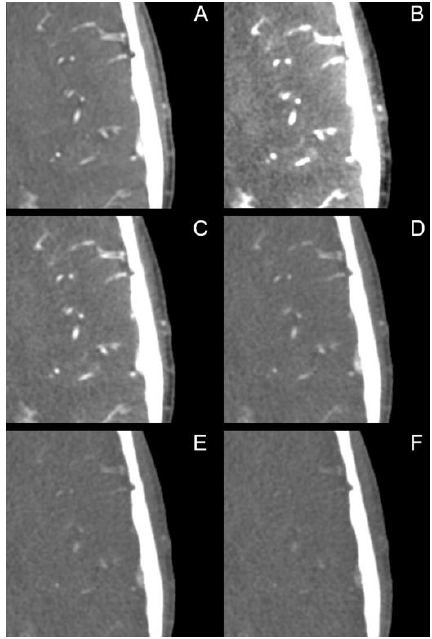
Figure 9. Visualization of small intrasulcal vessels in ( A ) polyenergetic reconstruction and monoenergetic reconstructions with ( B ) 40 keV, ( C ) 60 keV, ( D ) 80 keV, ( E ) 100 keV and ( F ) 120 keV. Window settings were identical in each image. In the qualitative analysis, the polyenergetic reconstruction was particularly superior in the assessment of small vessels.